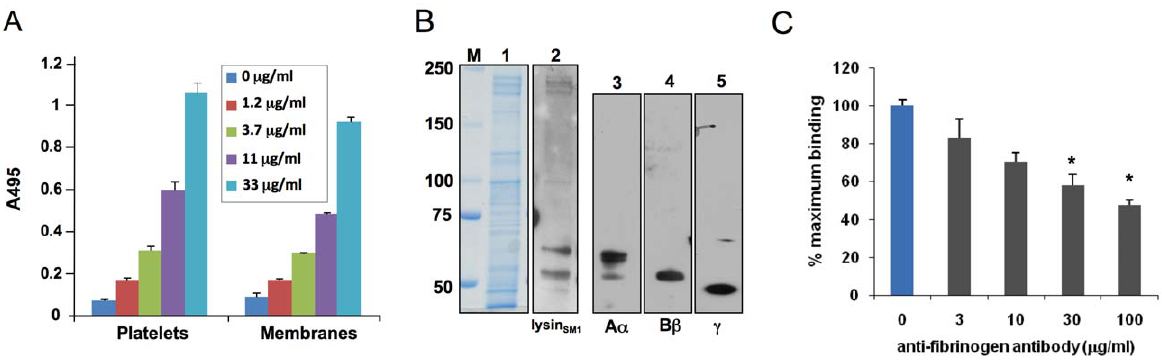
Figure 3. Lysin binding to platelet monolayers and platelet membranes. (A) Immobilized human platelets or platelet membranes were incubated with the indicated concentrations of purified FLAG lysin SM1 , washed, and bound FLAG lysin SM1 was assessed by ELISA. Bars indicate the means ( 6 S.D.) of triplicate data from a representative experiment. (B) Lysin SM1 binding to platelet membrane proteins (far Western blotting). Proteins were either stained with Coomassie blue (panel 1), or transferred to nitrocellulose membranes and probed with FLAG lysin SM1 (panel 2). Platelet membrane proteins were probed with anti-fibrinogen A a chain (panel 3), anti-fibrinogen B b chain (panel 4), or anti-fibrinogen c chain (panel 5) polyclonal antibodies. (C) Inhibition of FLAG lysin SM1 binding to platelet membranes by fibrinogen IgG polyclonal antibody. Immobilized platelet membranes were incubated with the indicated concentrations of rabbit anti-fibrinogen IgG prior to testing for binding by FLAG lysin SM1 (5 m g/ml). Bars indicate the means ( 6 S.D.) of triplicate results from a representative experiment. * = P , 0.05, compared with no antibody treatment.